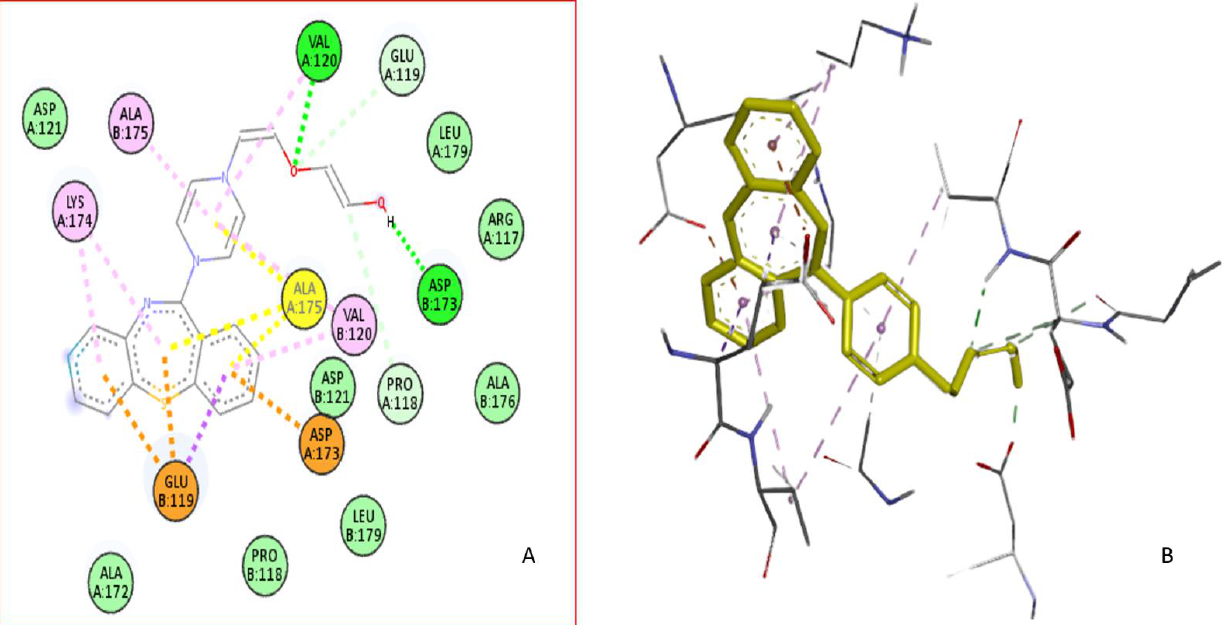
Figure 10. ( A ) The 2D binding site was magnified to show the surrounding amino acid residue of HSA interacting with QTP. ( B ) Three-dimensional structure of interactions of HSA with QTP.